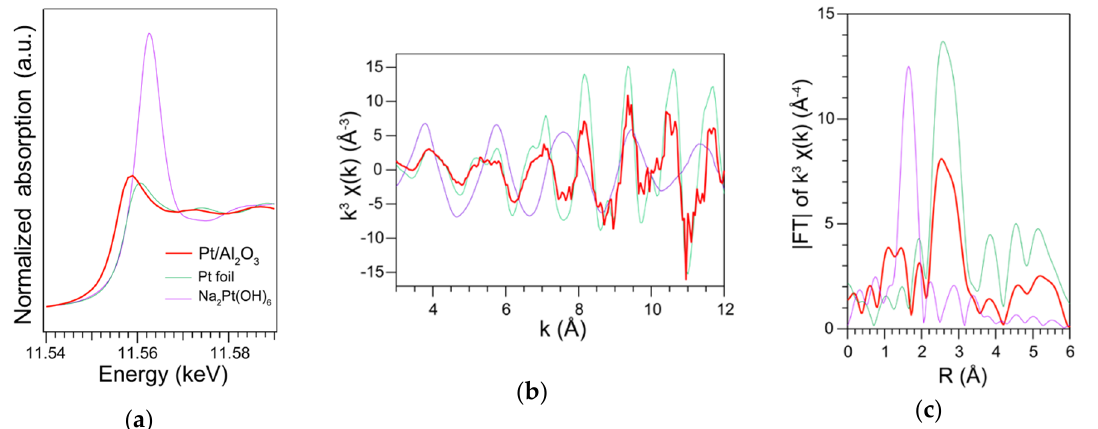
Figure 5. XAFS spectra of the 60 s ‐ sputtered and 300 °C ‐ calcined Pt/Al 2 O 3 substrate; reference samples of Pt foil and Na 2 Pt(OH) 6 . ( a ) XANES ( b ) EXAFS and ( c ) FT ‐ EXAFS.